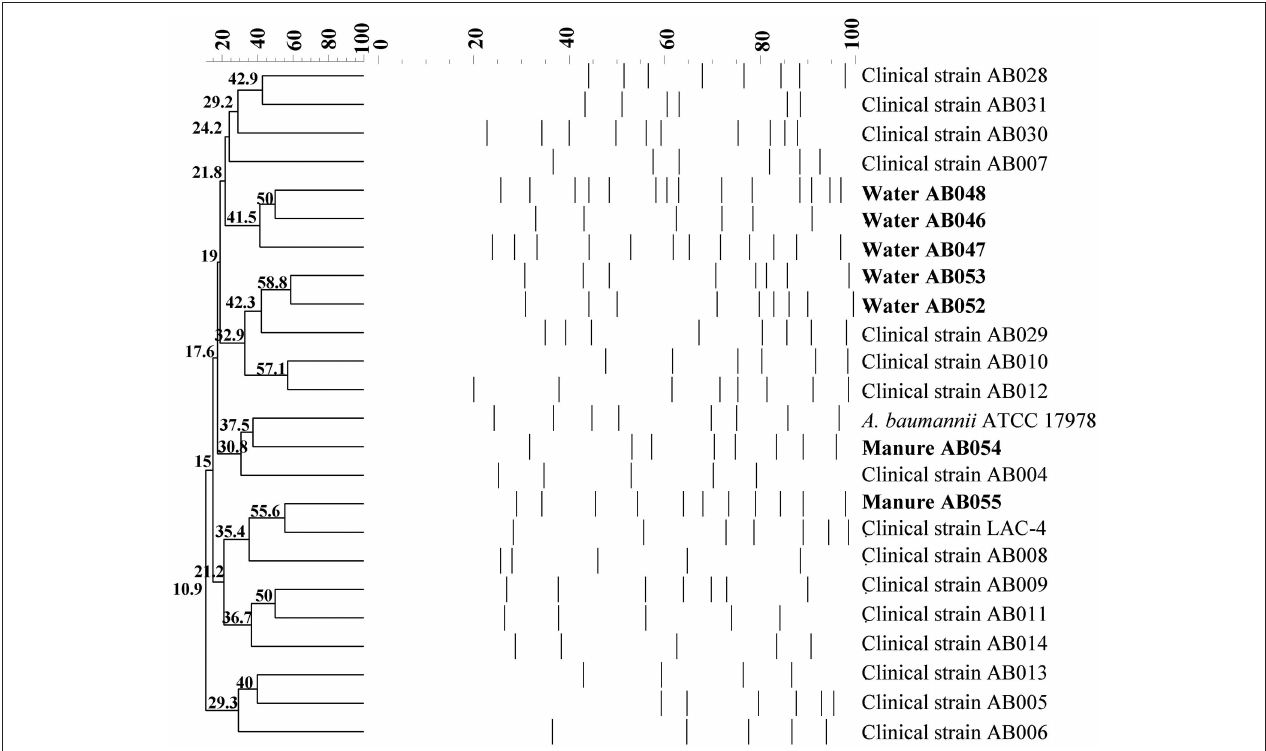
FIGURE 3 | Dendrogram analysis of Apa I PFGE patterns of chromosomal DNA of A. baumannii isolates where degree of similarity of macrorestriction patterns of 24 A. baumannii reference, environmental, and clinical strains are